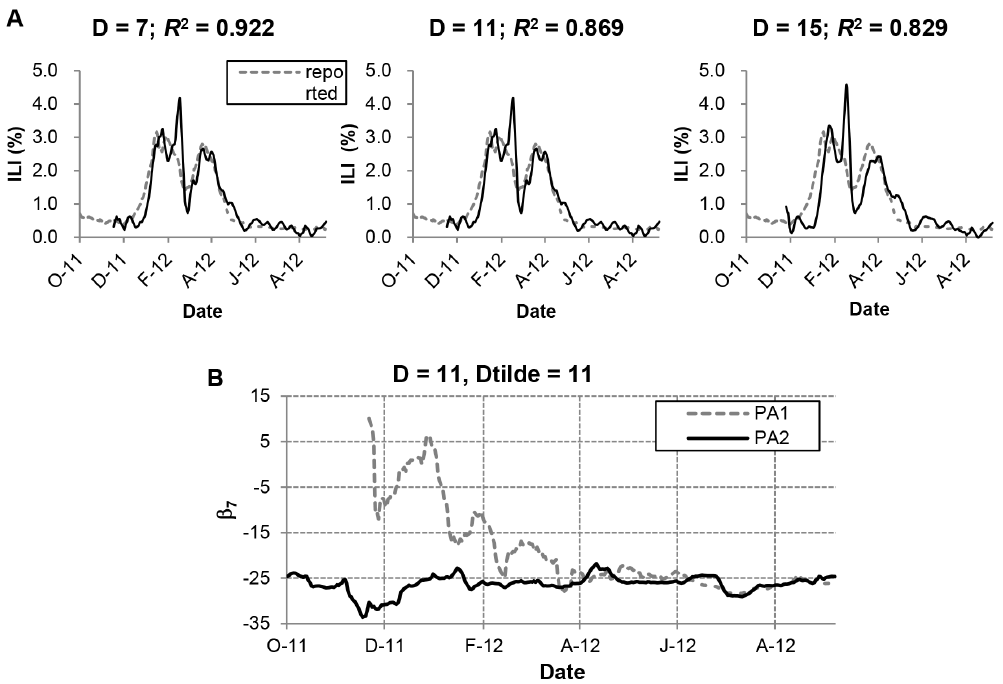
Figure 5. Estimation in the absence of ILI data. A) PA1: comparison of y and ^yy for D ~ 7,11,15 . The prediction error increases as D increases. B) Comparison of regression coefficients. ^ bb 7 versus days is plotted.